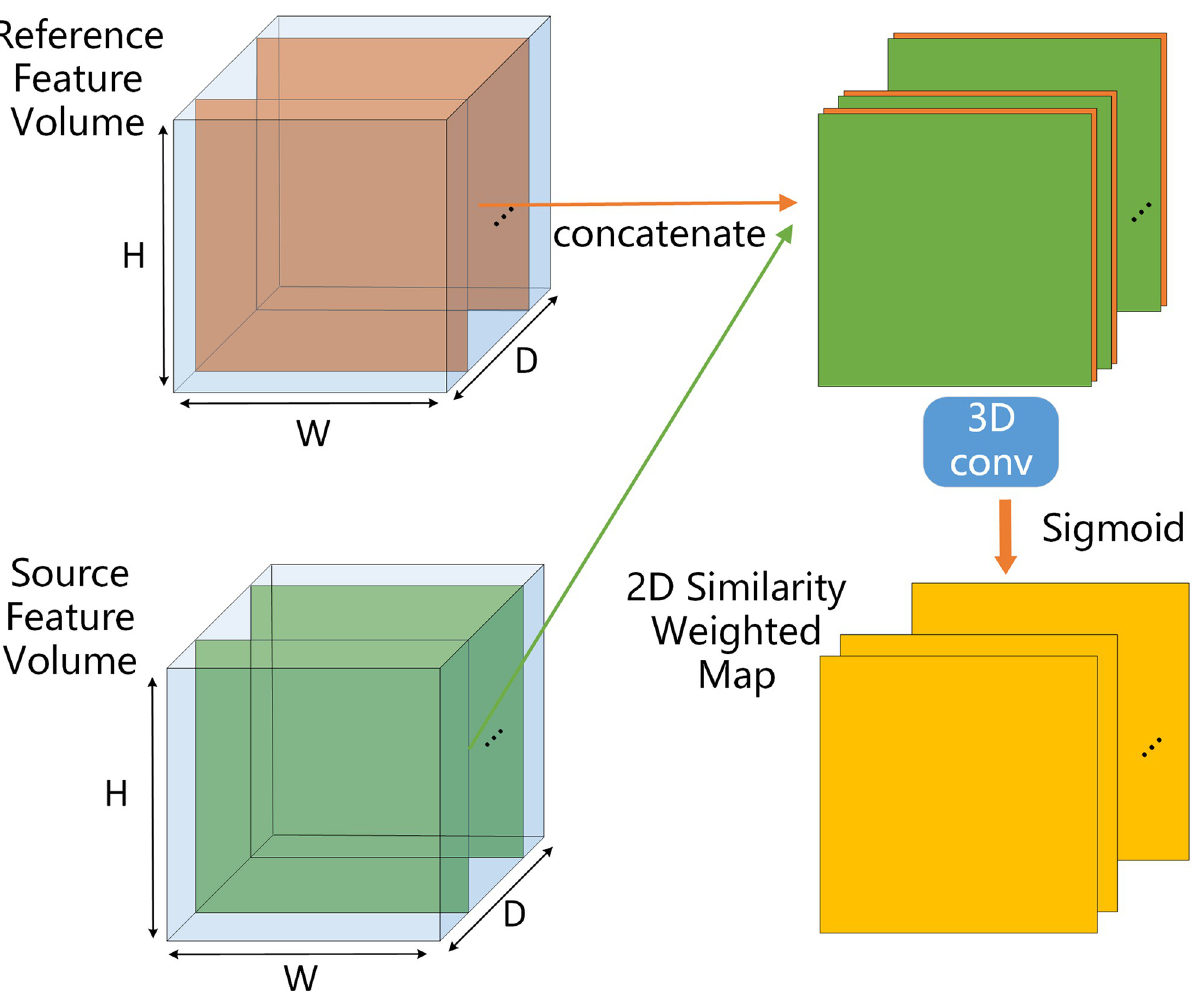
Fig 5. Illustration of cross-view similarity-based feature map fusion